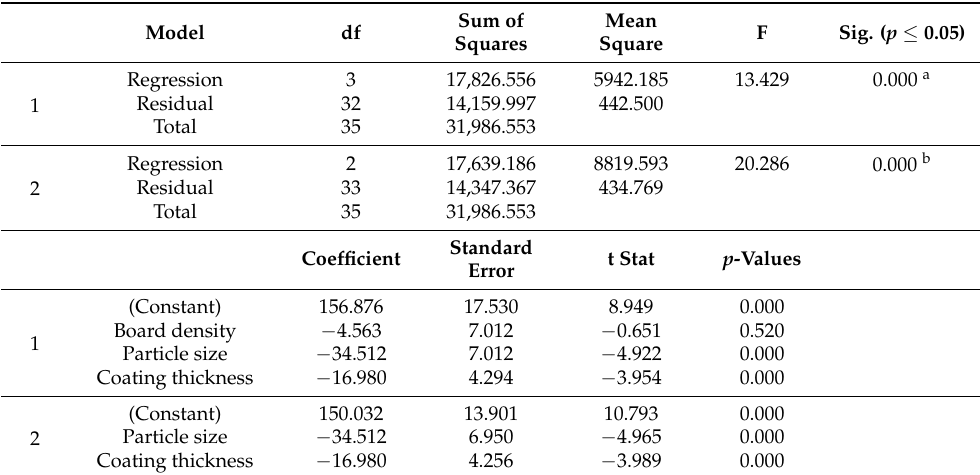
Table 5. Analysis of variance (ANOVA) of multiple regression for the effect of PU coating thickness, different particle size, and board density on the water absorption values.